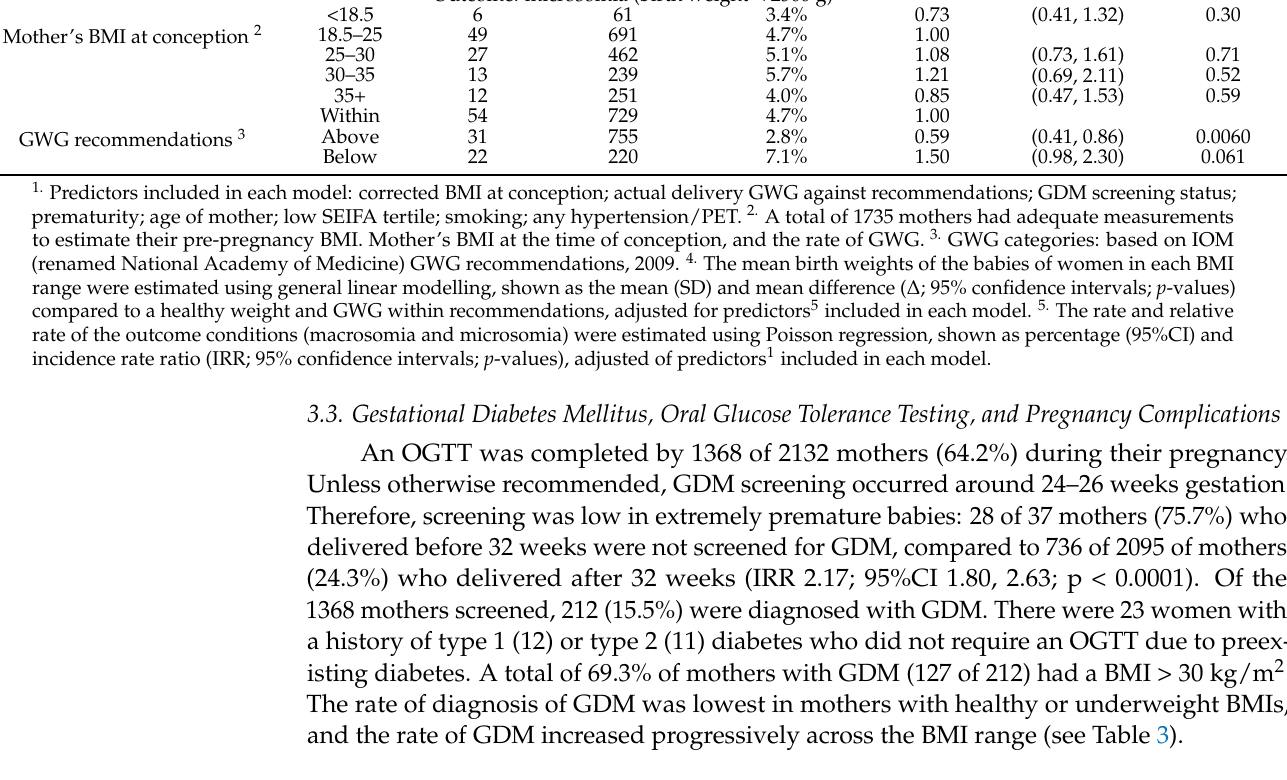
Table 3. Numbers (%) and relative risk (IRR) of mothers screened for GDM in different BMI